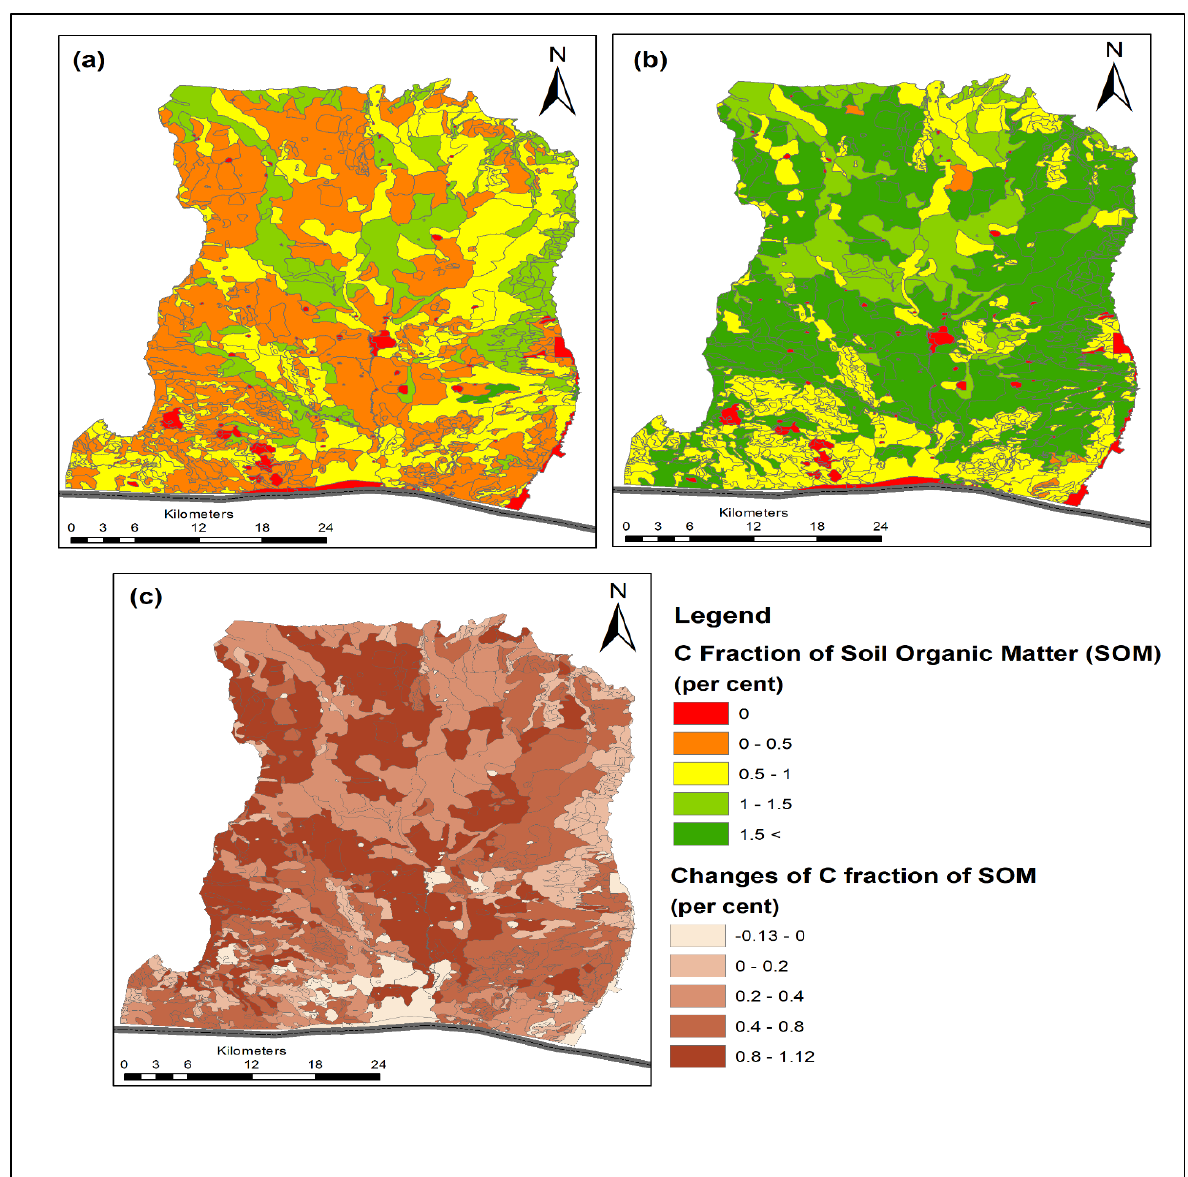
Figure 4: (a) SOC % in 1988, (b) SOC % in 2017; and (c) Changes of SOC between 1988 and 2018. Source: Authors,